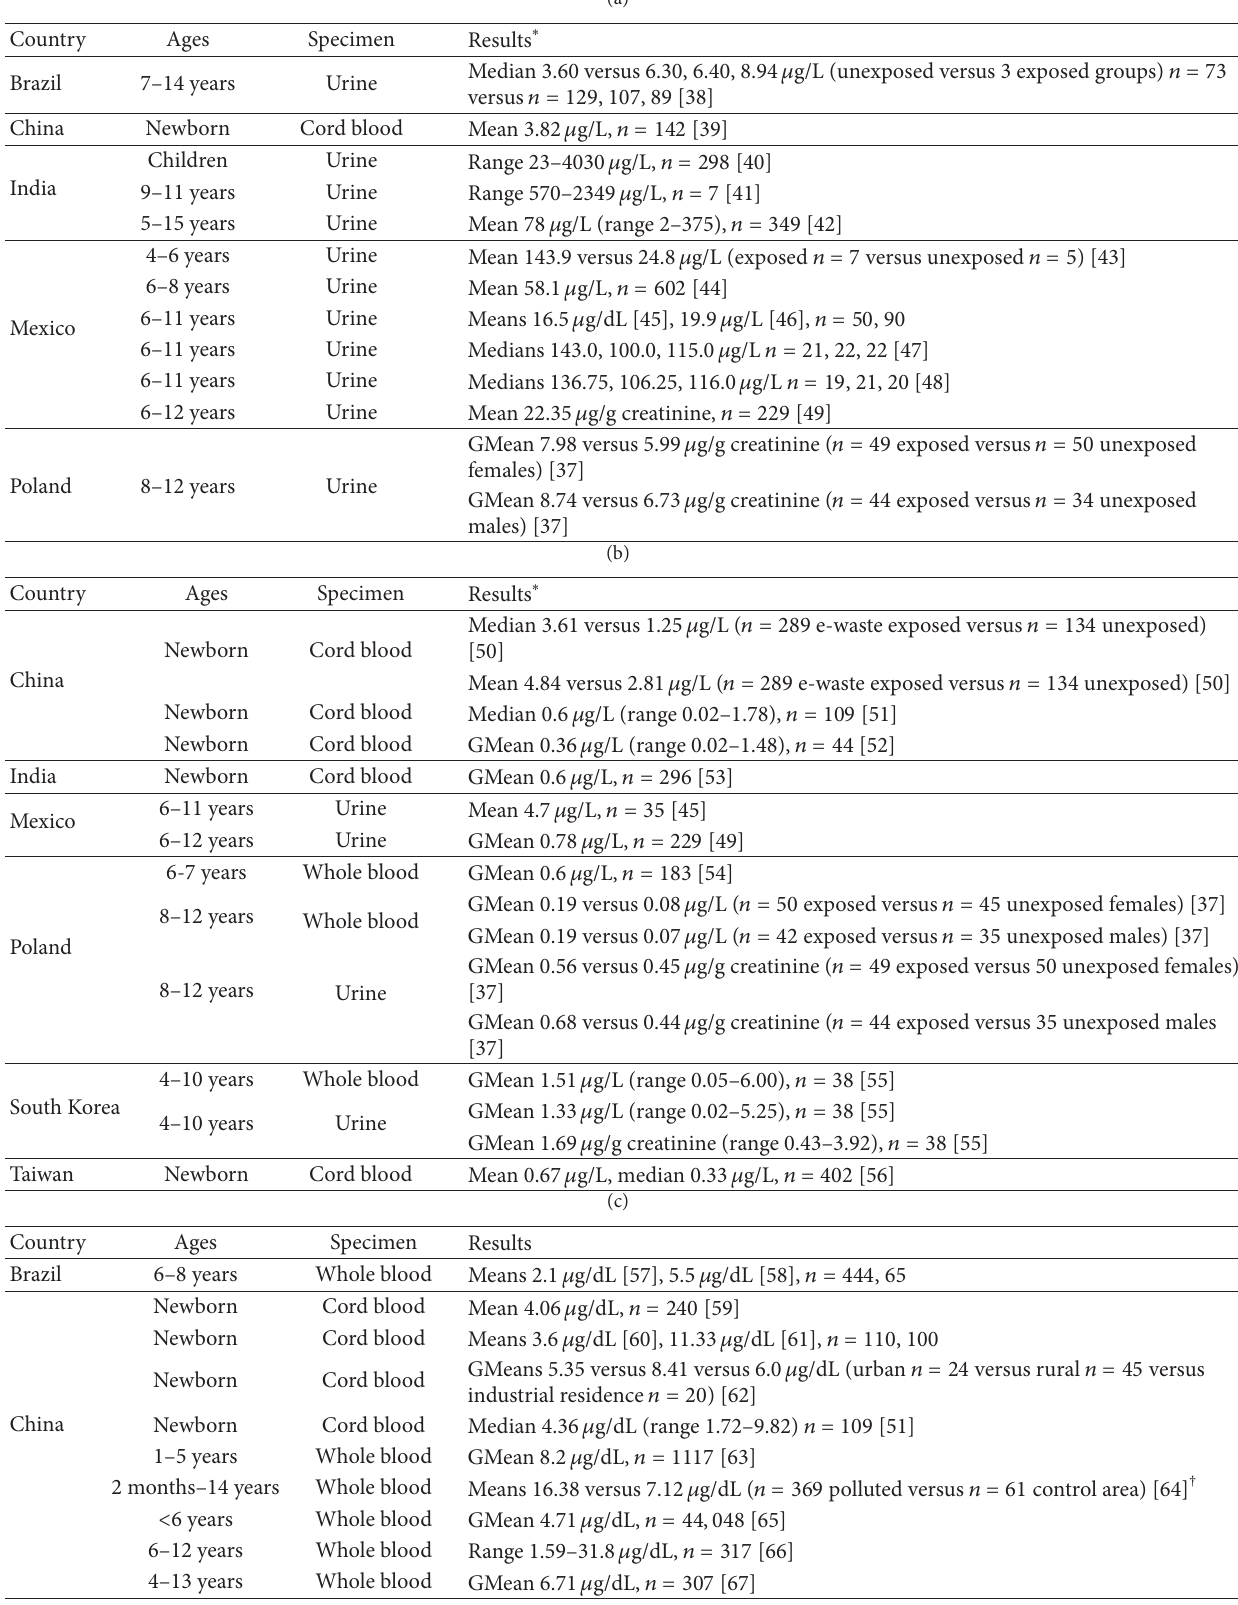
T 2: Summary of published studies reporting childhood exposures to (a) arsenic, (b) cadmium, (c) lead, and (d) mercury in Emerging Market